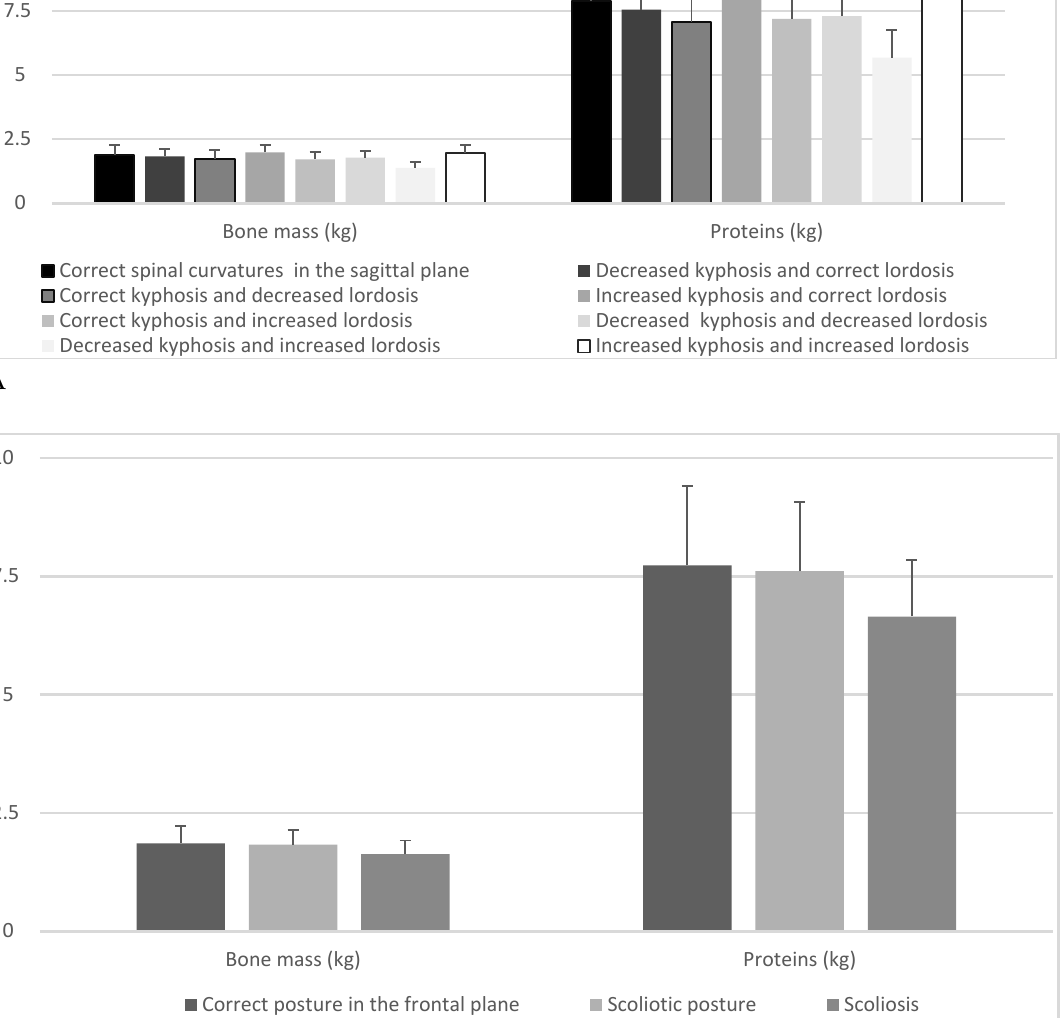
Figure 5. Bone mass, proteins and: sagittal spine types ( A ) and correct posture in the frontal plane, scoliotic posture and scoliosis ( B ).